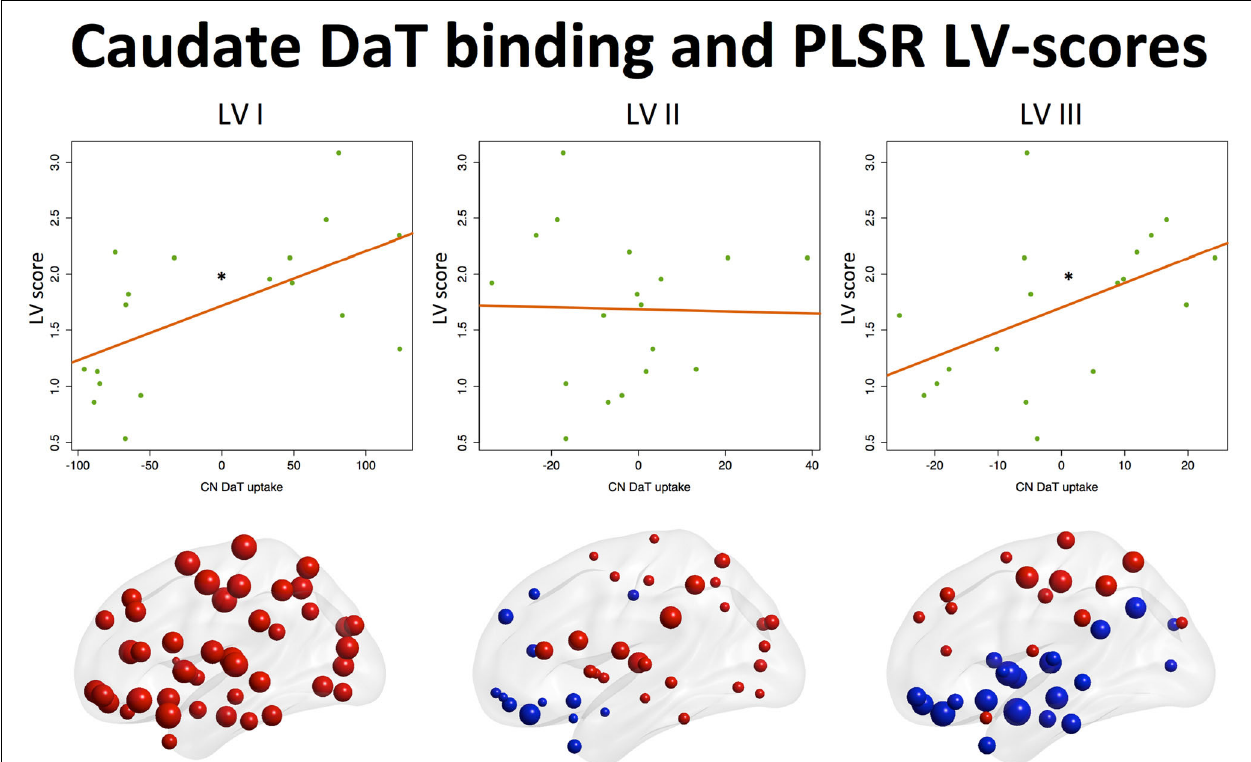
FIGURE 2 | Associations between component scores and mean caudate DaT binding. Associations of latent variable (LV) scores extracted from the nodal strength data with nigrostriatal dopaminergic function measured by 123 I-FP-CIT SPECT (mean caudate SBR ratios). Positive associations ( ∗ p < 0 . 05) were found for the Ist (“global/motor”)